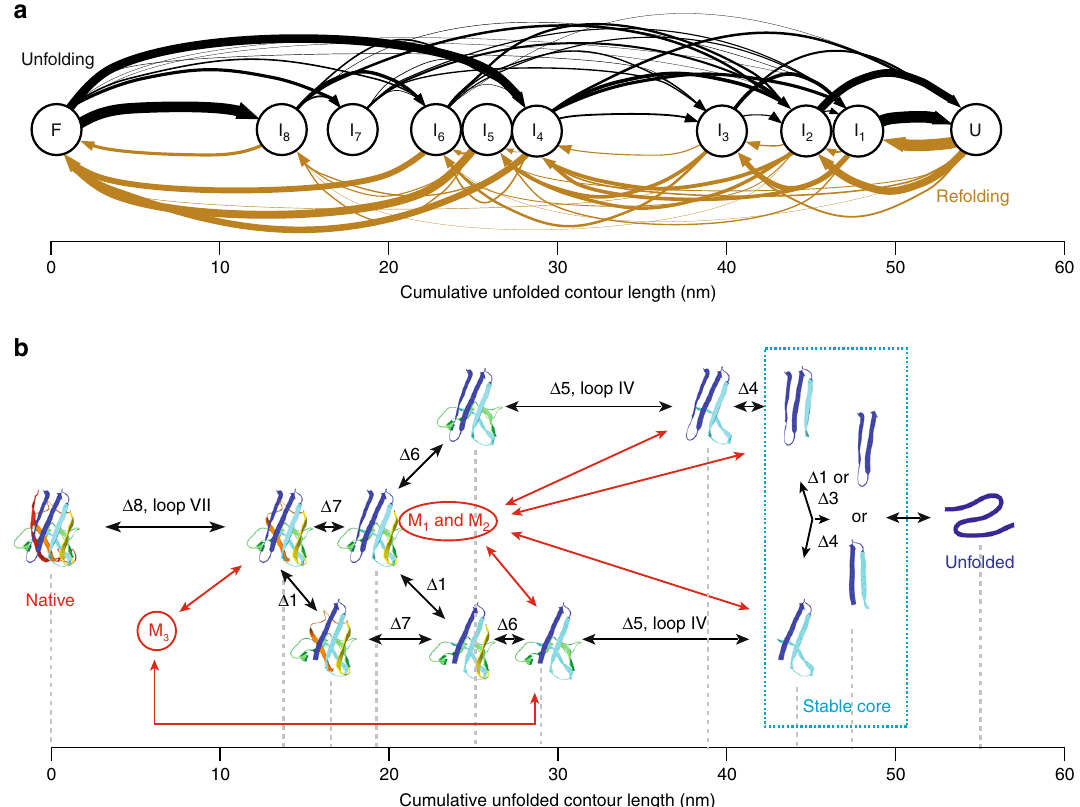
Fig. 3 Folding pathways of monomeric SOD1. a Map of the experimentally observed transitions between intermediates in FECs showing native unfolding (black) and refolding (brown). Intermediates assigned based on the cumulative Δ L c values. Arrows re fl ect all pairwise transitions between states, with line thickness representing the relative frequency of the transition. b Proposed structures of the intermediate states for native unfolding/refolding and dominant pathways between them (black), as deduced from a network analysis of the transitions. The intermediates have cumulative unfolded contour lengths consistent with the sequential removal/addition of individual β -strands in the native structure. The stable core that unfolds last and refolds fi rst is indicated by the box. Misfolded states branch off from the native pathways (red) after formation of the stable core, indicating that partially native intermediates mediate the